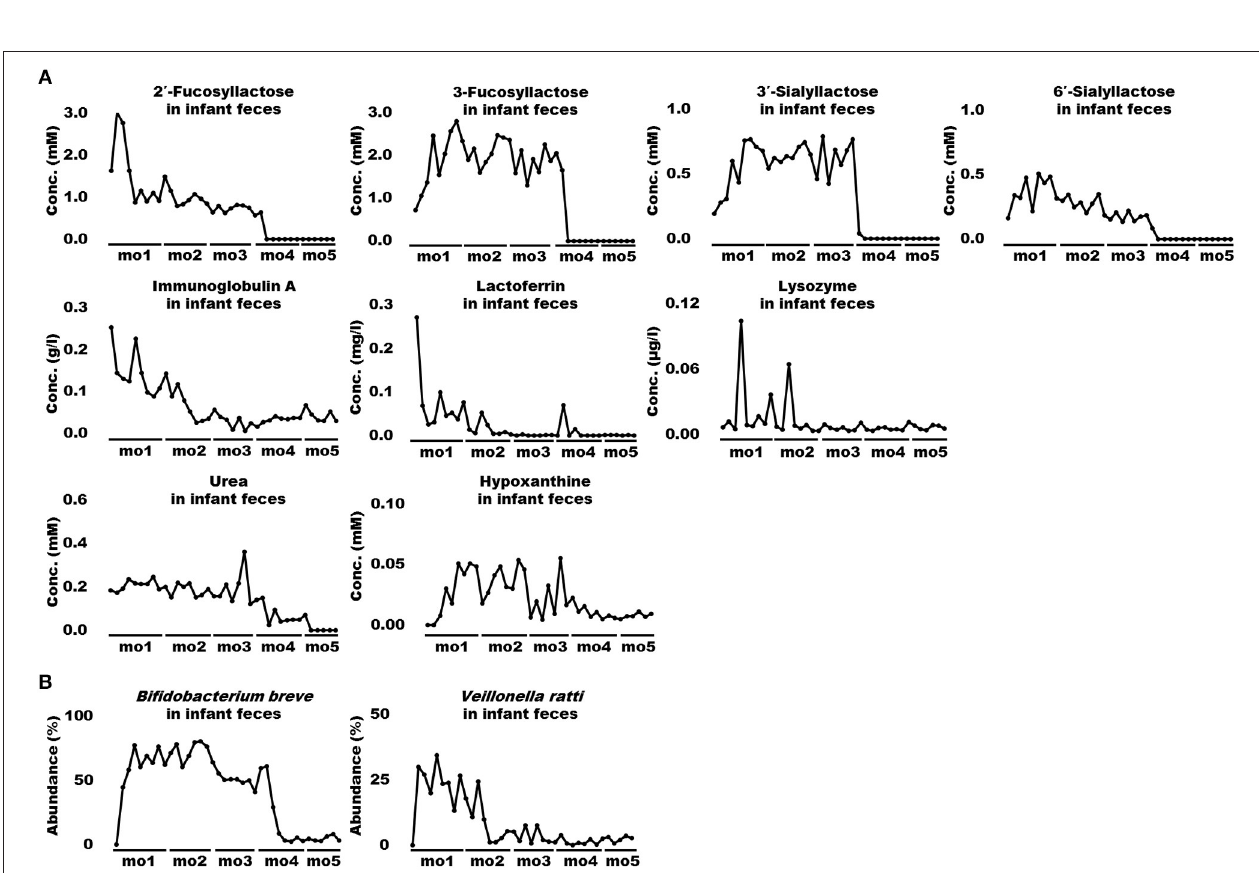
FIGURE 4 | Changes in bioactive milk components, microbiome, and metabolites in infant feces with high similarity in cluster A. (A) Human milk oligosaccharides (2 ′ -fucosyllactose, 3-fucosyllactose, 3 ′ -sialyllactose, and 6 ′ -sialyllactose), antibacterial proteins (immunoglobulin A, lactoferrin, and lysozyme), urea, and hypoxanthine in infant feces. (B) Bifidobacterium breve and Veillonella ratti , in infant feces. mo, month.